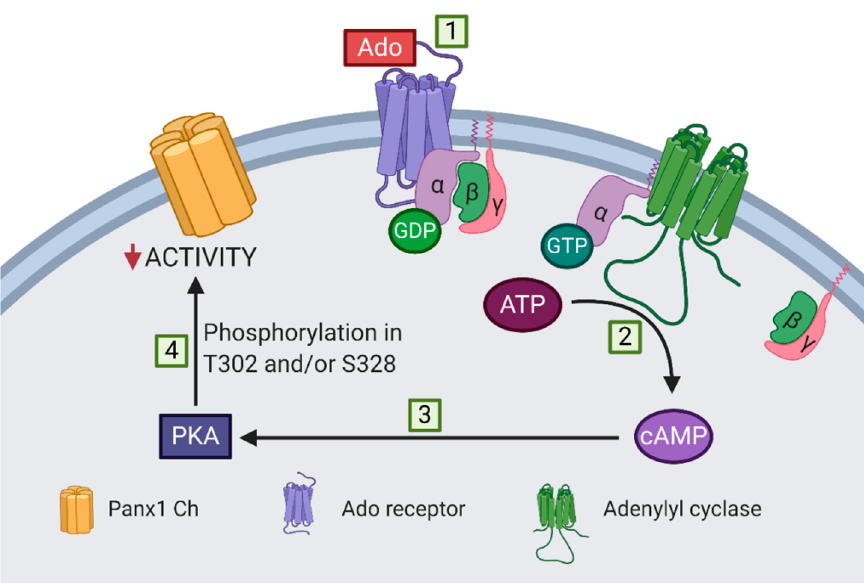
Figure 6. Proposed model of adenosine-dependent inhibition of mechanically stretched Panx1 channels. (1) Adenosine activates receptors associated with the α s subunit, i.e., A 2A and A 2B receptors, (2) which induce an increase in cytoplasmic cAMP, probably via the activation of adenylyl cyclase. (3) PKA is activated upon an increase in cytoplasmic cAMP, (4) mediating the inhibition of Panx1 channels (Panx1 Ch) through the phosphorylation of T302 or S328 residues.